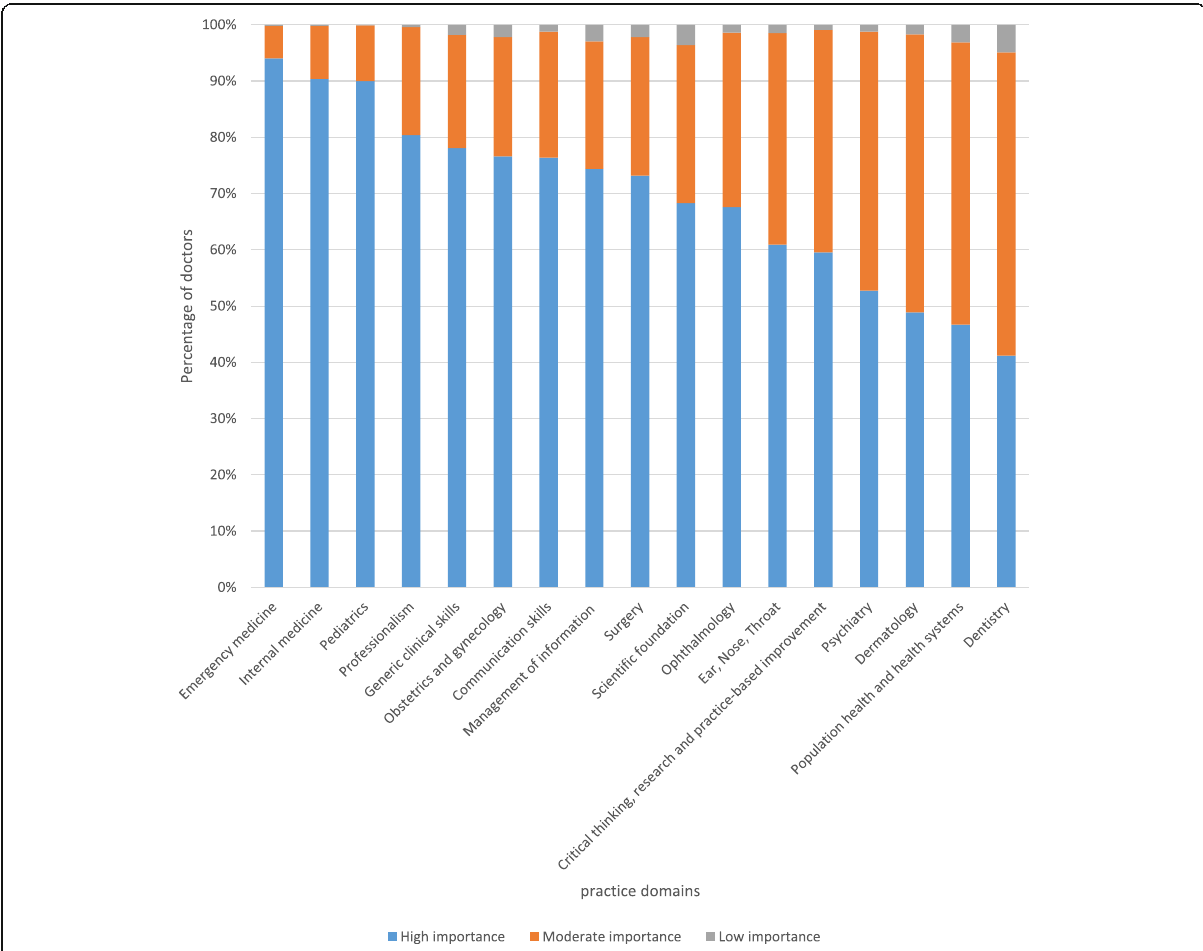
Fig. 1 Junior doctors ’ perceptions about importance of tasks summarized by practice domain, Ethiopia, 2015 ( N =